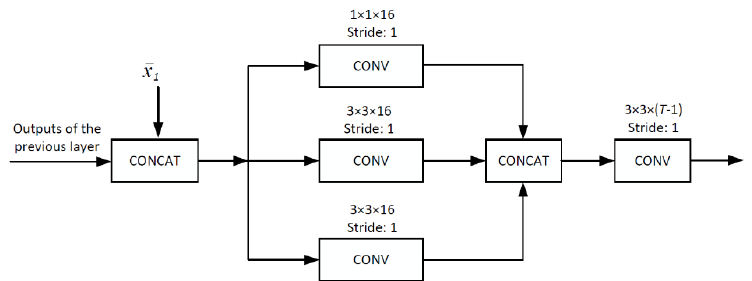
Figure 5. BU. The inputs are the intermediate reconstruction of key frame x 1 and the outputs of the previous layer.